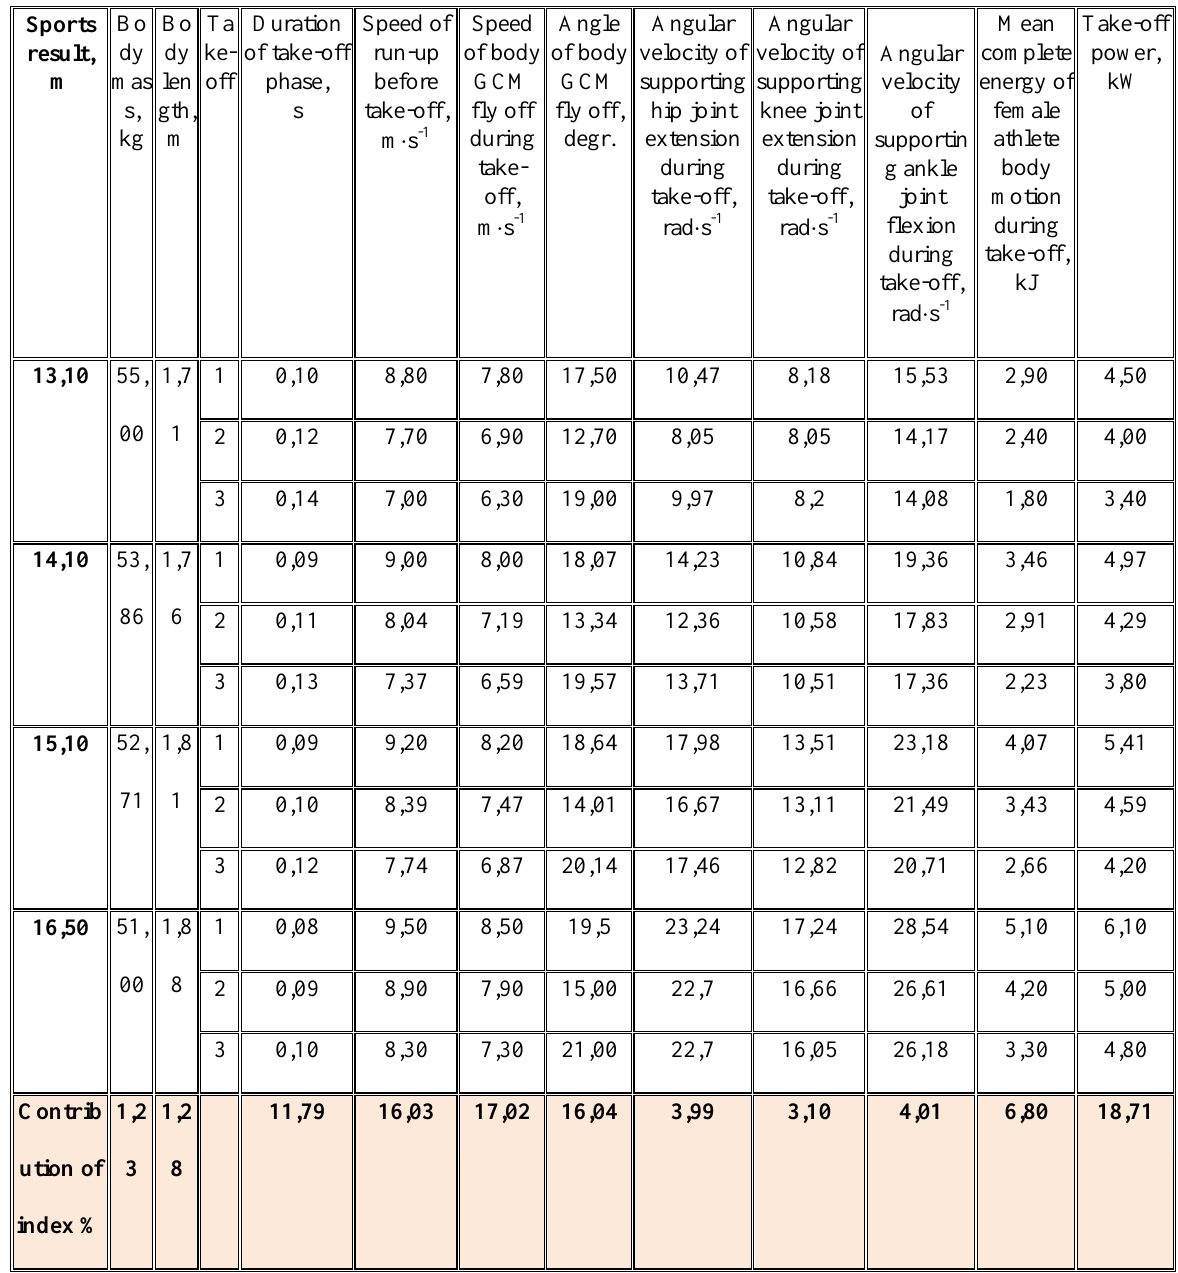
Quantitative characteristics of motor actions multifunctional biomechanical models, providing the achievement of targeted sports results in triple jump